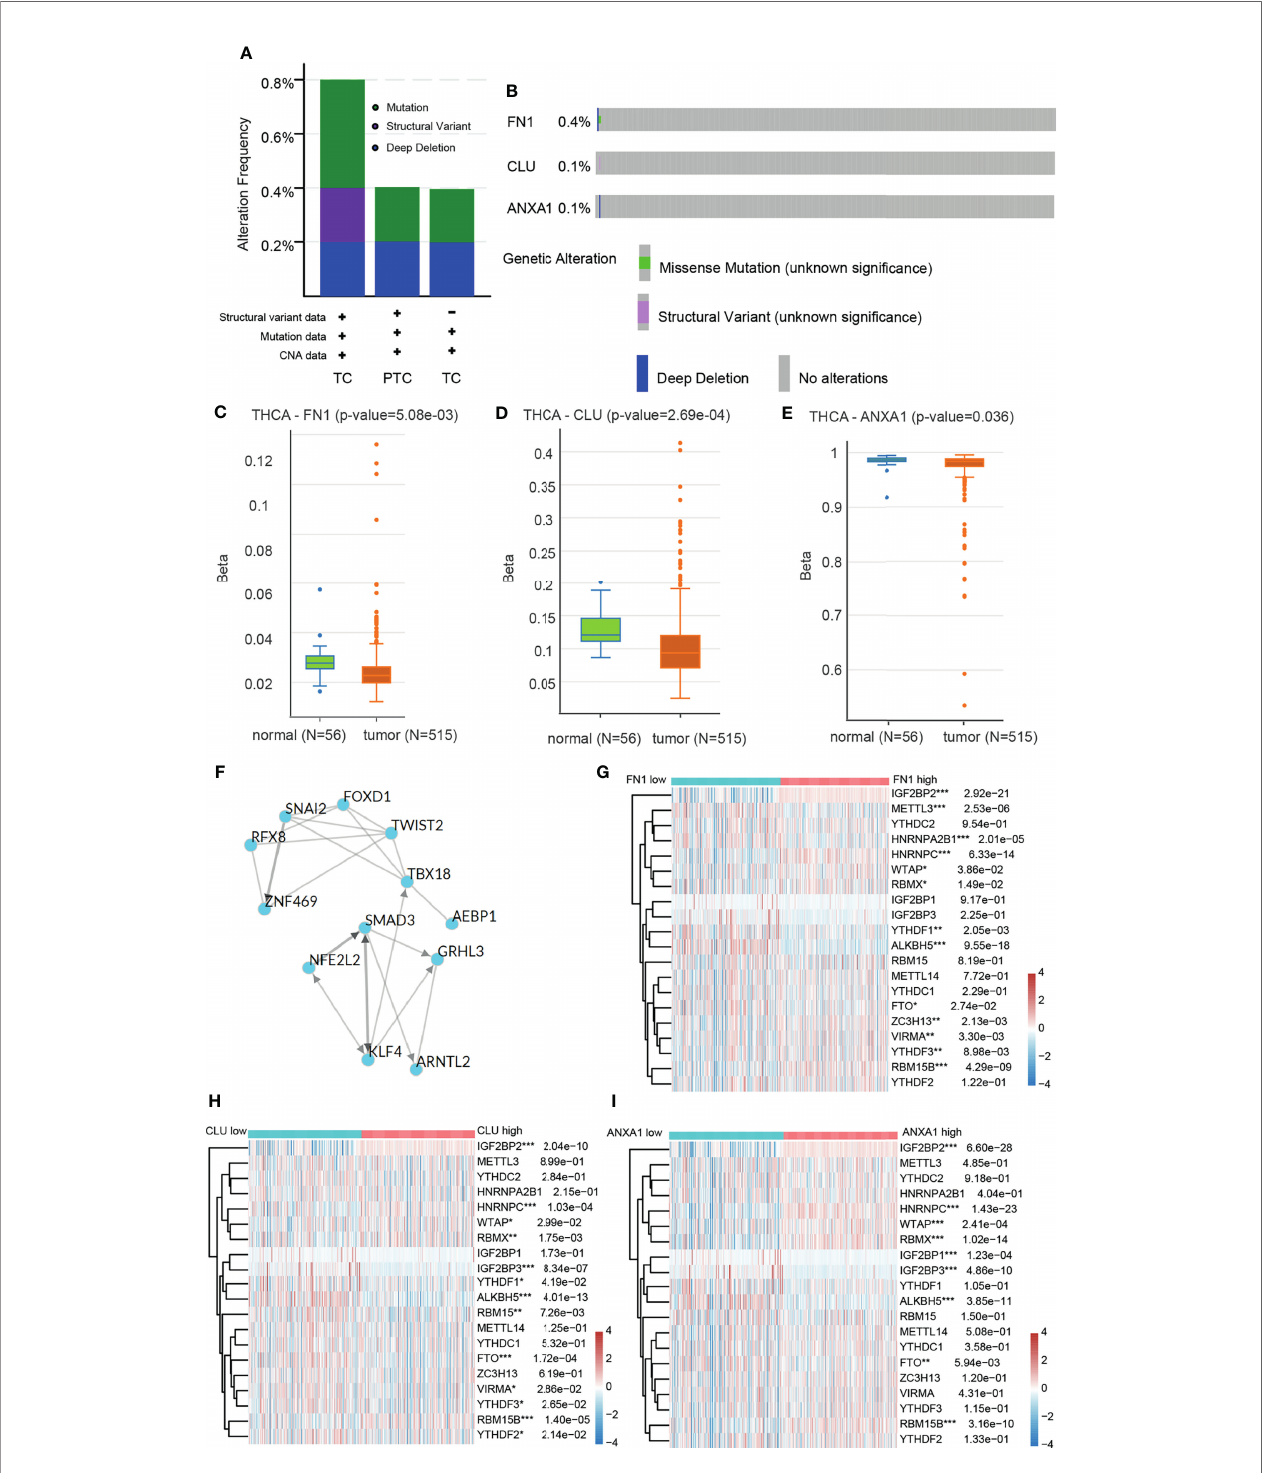
FIGURE 5 | Analysis of regulatory network based on multi-omics data. (A) The overall frequency of 3 prognostic related genome-level alteration in THCA (Firehose Legacy), PTC (Cell 2014), THCA (PanCancer Atlas) of DEGs. (B) The separated frequency of 3 prognostic related genome-level alteration of DEGs in THCA (Firehose Legacy), PTC (Cell 2014), THCA (PanCancer Atlas). (C – E) DNA methylation levels of 3 DEGs between tumor tissues and adjacent tissues in THCA. (F) Interaction between transcription factors regulating 3 DEGs. (G – I) Heatmap of the relationship between m6A related genes and 3 DEGs. *p ≤ 0.05; **p ≤ 0.01; ***p ≤